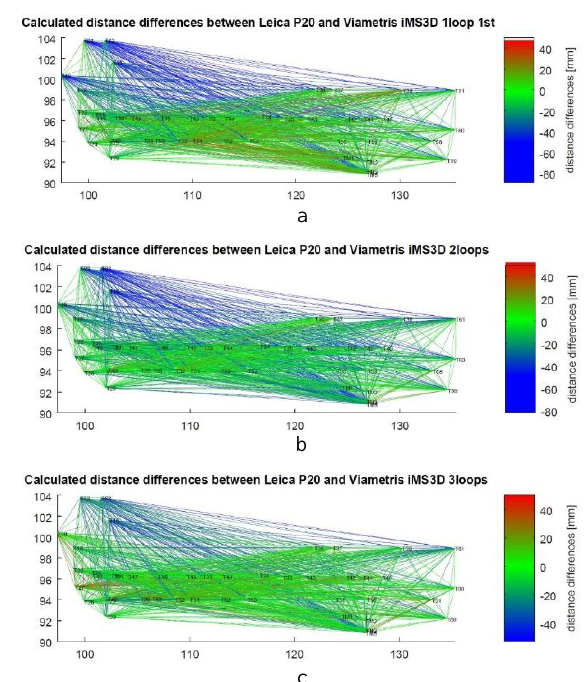
Figure 10. Effect of increasing number of loops; a) one loop, b) two loops, and c) three